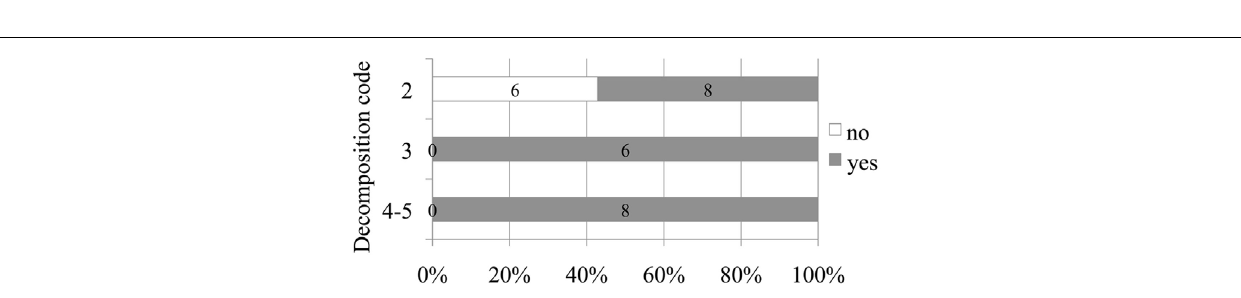
Frontiers in Physiology | Aquatic